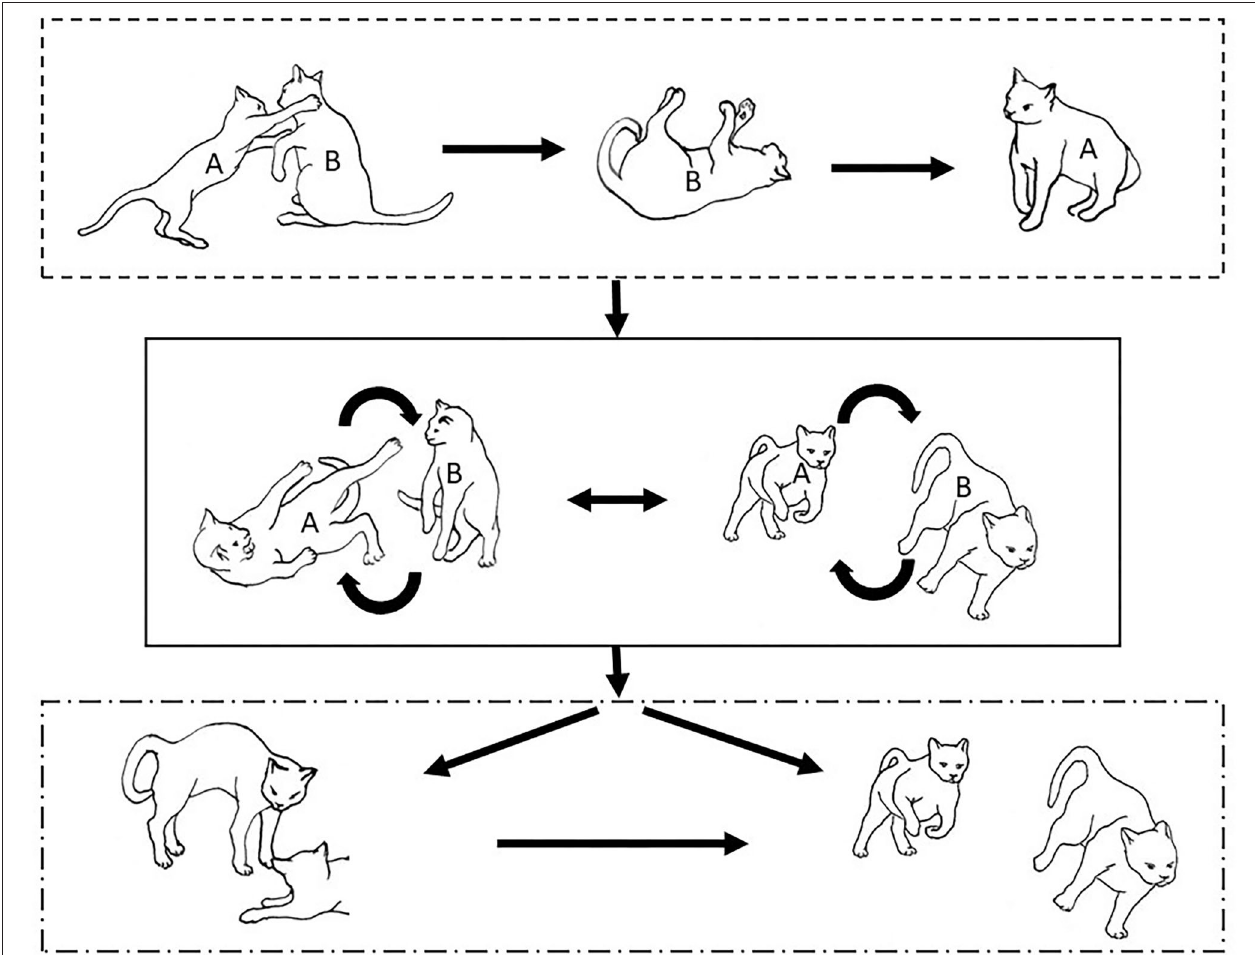
FIGURE 3 | Sequences involved in mutual social play [inspired by (34)]. Top box represents sequences which often form part of initiation of the play, middle box includes those which are seen in continuation of the play and in the bottom box, behaviours which can terminate mutual social play bout without aggressive interaction, are